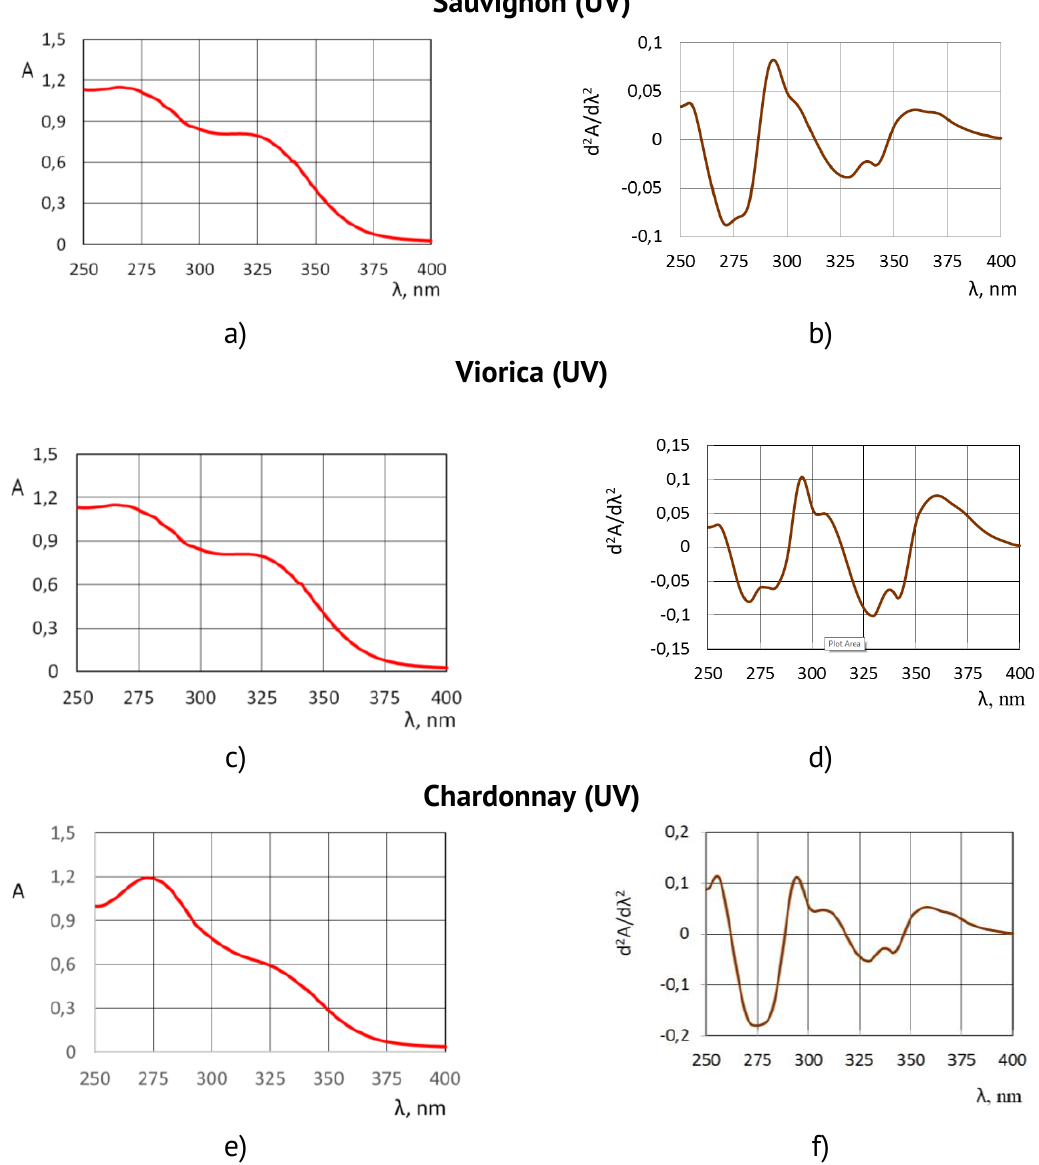
Figure 2. The absorption spectra of experimental raw wines Sauvignon (a), Viorica (c), Chardonnay (e) and its second order derivative spectra (b, d, f). The wines are undiluted, the cuvettes path length – 0,1